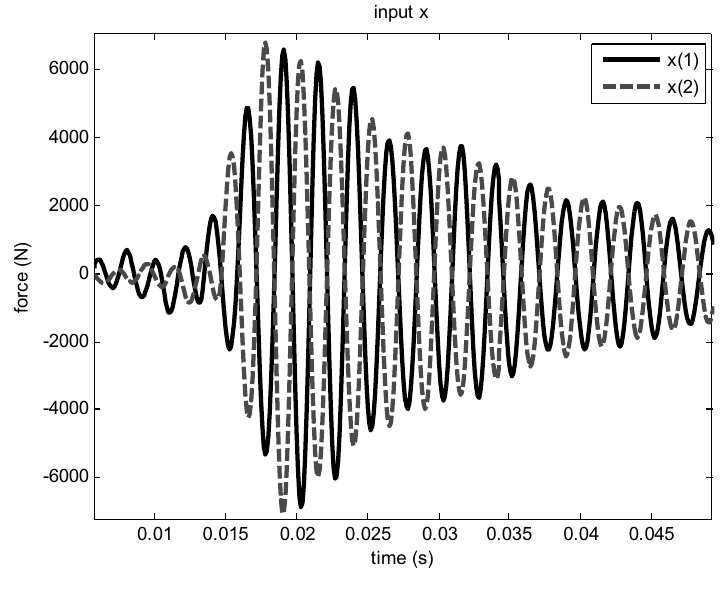
Fig. 27. Example 4, Time histories of the